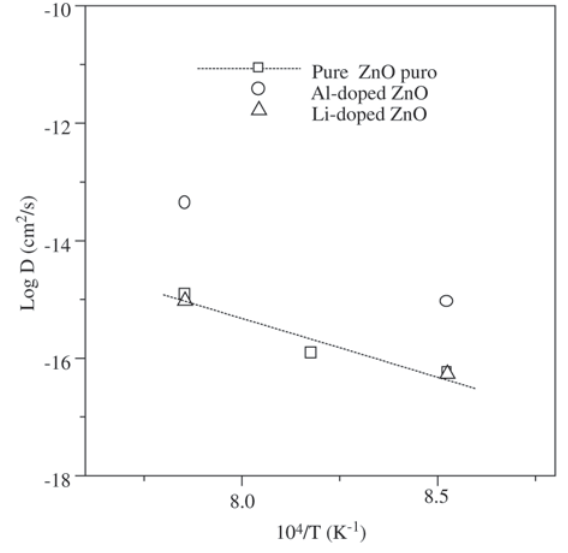
Figure 3. Arrhenius plot for 18 O in pure ZnO, Li-doped ZnO and Al-doped ZnO.